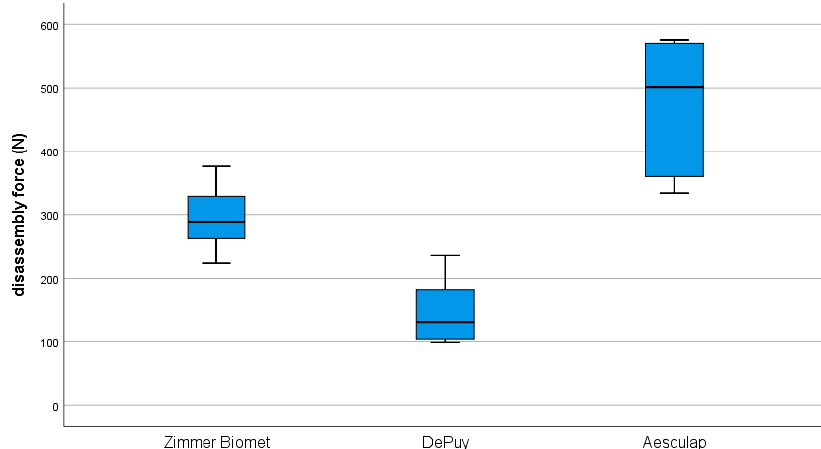
Figure 6. Resulting maximum axial disassembling forces.